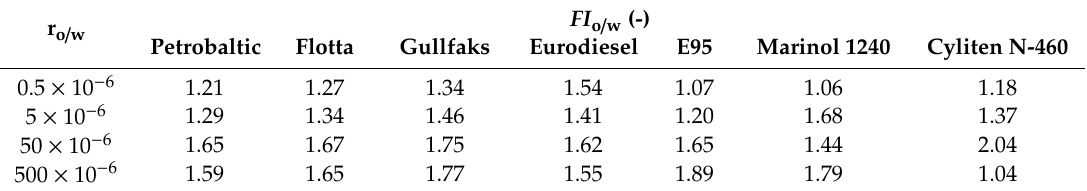
Table 5. Fluorometric index ( FI o / w ) calculated by Formula (2) for the seawater contaminated with individual oils on 20 May